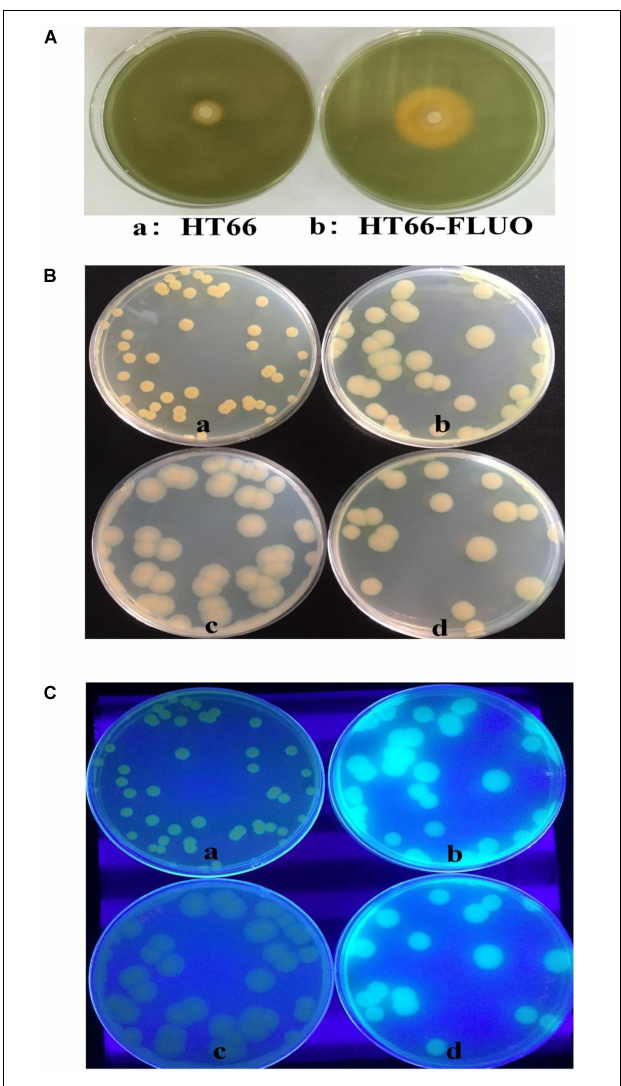
FIGURE 2 | Siderophore biosynthesis assays. (A) Determination of siderophore production of P. chlororaphis HT66 and HT66-FLUO on CAS blue agar plates. The bacteria were incubated for 60 h at 28 ◦ C. The siderophore production is indicated by the size of the orange zone on the center of CAS plates. (B) Comparison of the morphology. (C) Comparison of the fluorescence phenomenon under UV light. The strains were grown on KB agar plates at 28 ◦ C for 60 h. HT66 (a), HT66-FLUO (b), HT66-FLUO (cid:49) pvdA (c), HT66-FLUO (cid:49) pvdA - pvdA